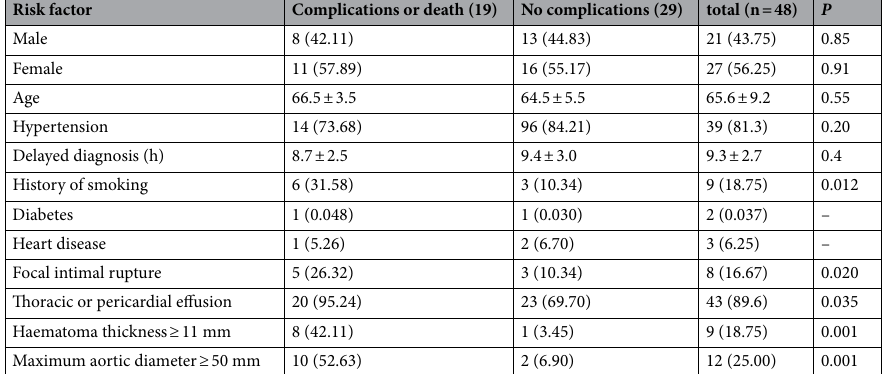
Table 2. Comparison of risk factors in Stanford type A patients with or without complications.